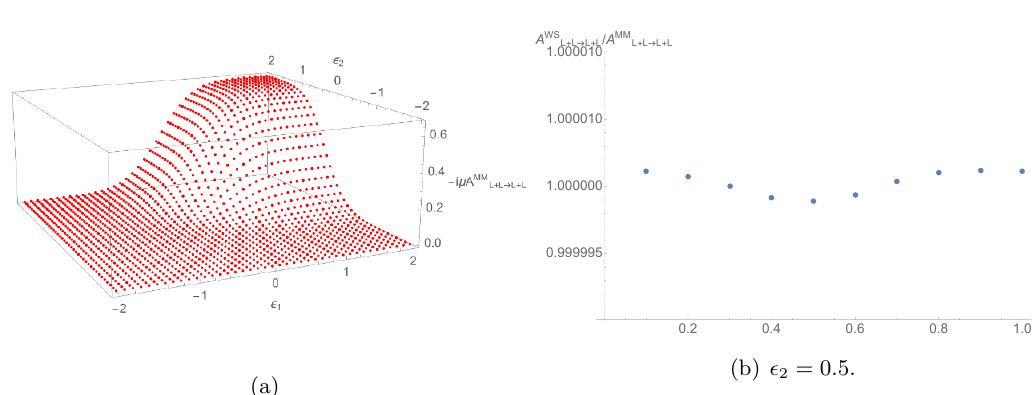
Figure 15 . (a): numerical results for the matrix model scattering of the tree level long + long ! long + long amplitude (4.36) as a function of incoming long string renormalized energies (cid:15) 1 ; (cid:15) 2 at (cid:12)xed outgoing long string renormalized energy (cid:15) 3 = 0 : 5. (b): ratio of numerical results computed from the worldsheet to those computed from the matrix model for tree-level long + long ! long + long string